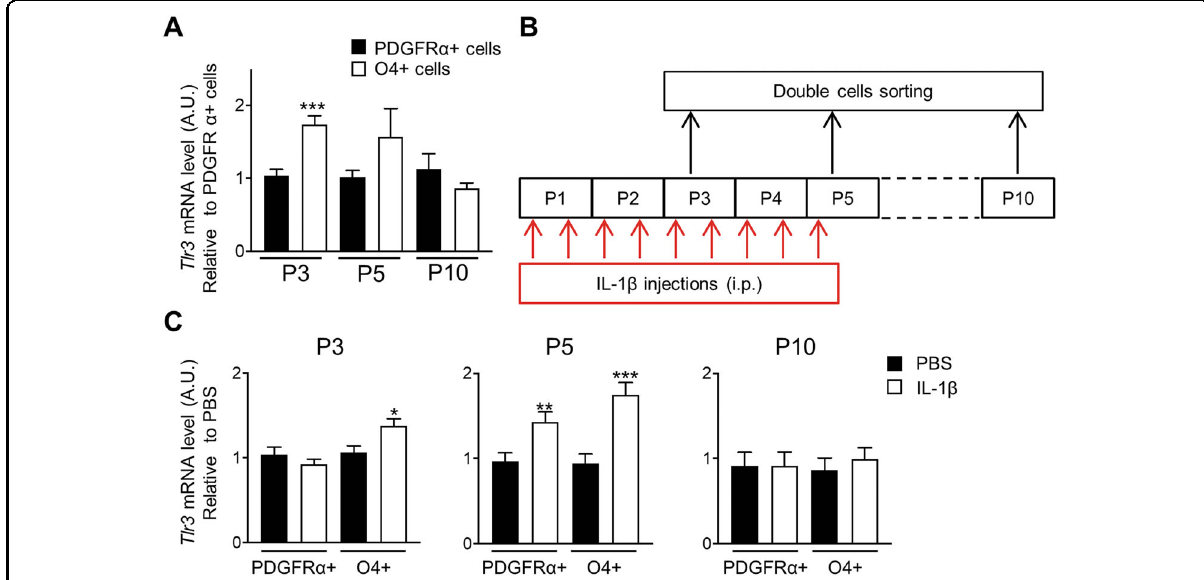
Fig. 2 Tlr3 expression is differentially regulated in PDGFR α + OPCs and O4 + immOLs during development and is induced after IL-1 β treatment. A qPCR analysis of Tlr3 expression in PDGFR α + OPCs and O4 + immOLs at different postnatal days (P3, P5, and P10) form control male mice brain (data are mean ± SEM, n = 10 groups/condition from two independent experiments for P3 and P10 and n = 17 groups/condition from three independent experiments at P5, *** p < 0.001 Unpaired t -Test). B Experimental scheme. C Tlr3 expression assessed by qPCR in control and IL-1 β treated mice in PDGFR α + and O4 + sorted cells (data are mean ± SEM, n = 10 groups/condition from 2 independent experiments at P3 and P10, n = 18 from 3 independent experiments at P5, * P < 0.05, ** P < 0.01, *** P < 0.001 Unpaired t